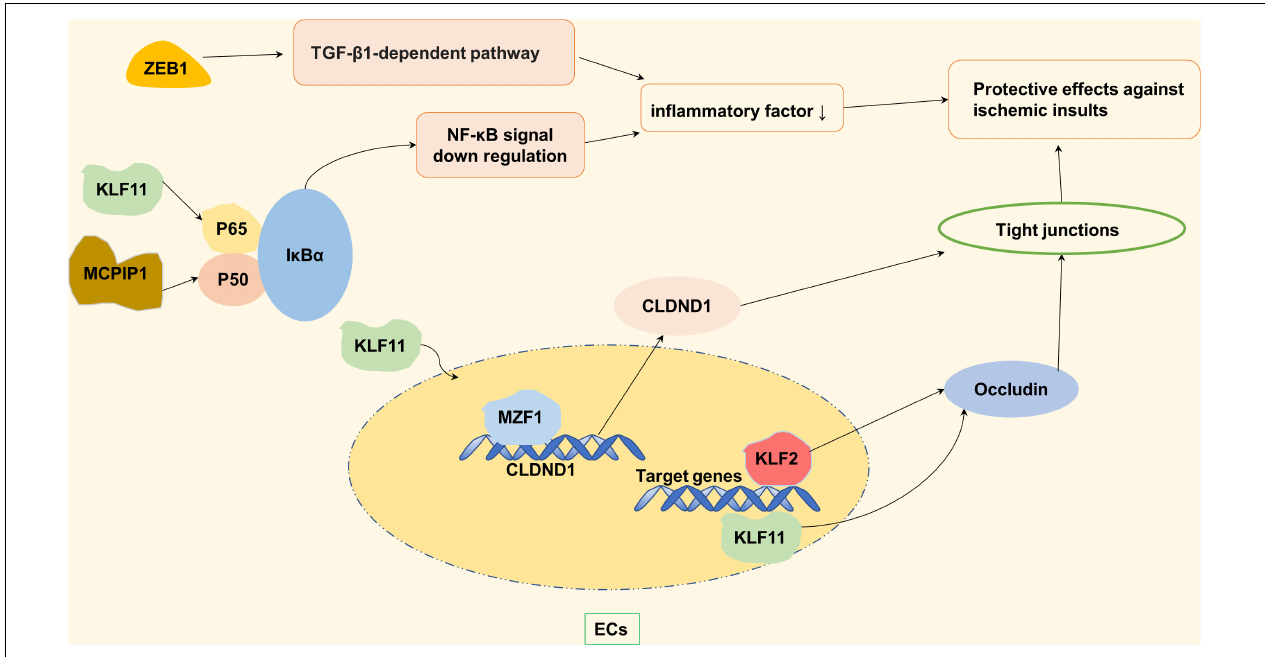
FIGURE 2 | Zinc finger proteins (ZNF) associated with protective effects against ischemic insults. KLF2 and KLF11 maintain the function of blood brain barrier (BBB) by regulating the occludin in the vascular endothelial cells. KLF11 and MCPIP-1 reduce the level of inflammatory factors by negatively regulating NF- κ B pathway, thus protecting BBB. MZFI promotes TJs synthesis by increasing the mRNA and protein expression levels of its potential binding site CLDND1, and regulates vascular permeability.